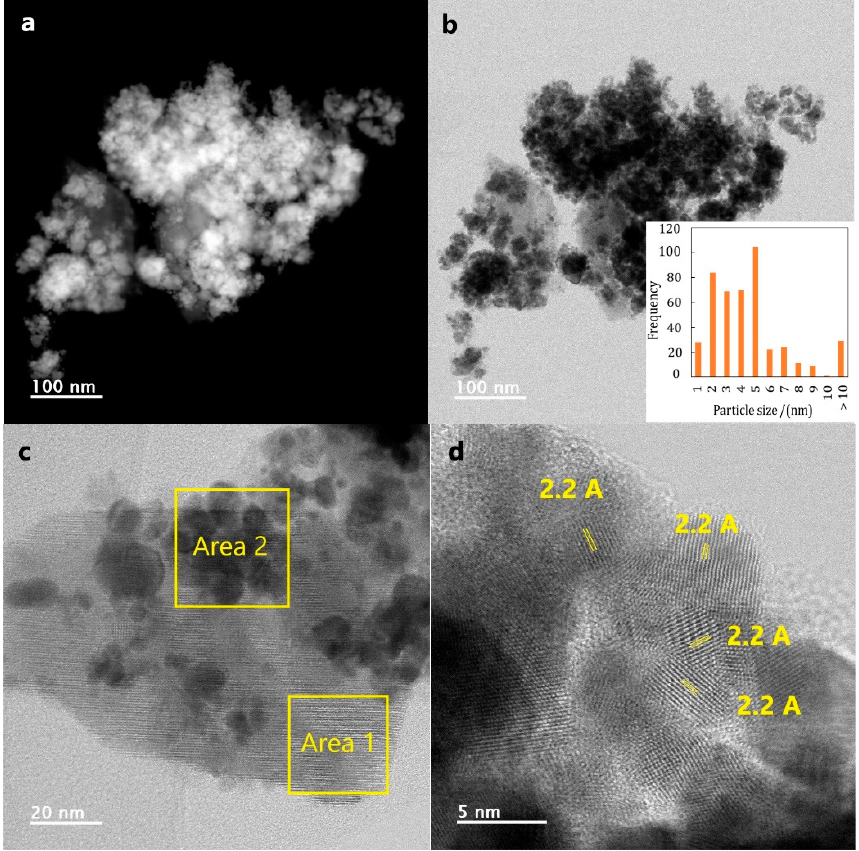
Figure 4. TEM images of Ir-Sn-Sb-O ( a ) STEM bright field mode, ( b ) STEM dark field image, insert: particle size distribution ( c ) TEM micrographs of nanoparticles, insert: selected areas for EDS analysis, ( d ) HRTEM images of nanoparticles, show the d spacing lattice. Table 2. EDS analysis for three selected areas for ATO, IrO 2 and Ir-Sn-Sb-O materials.